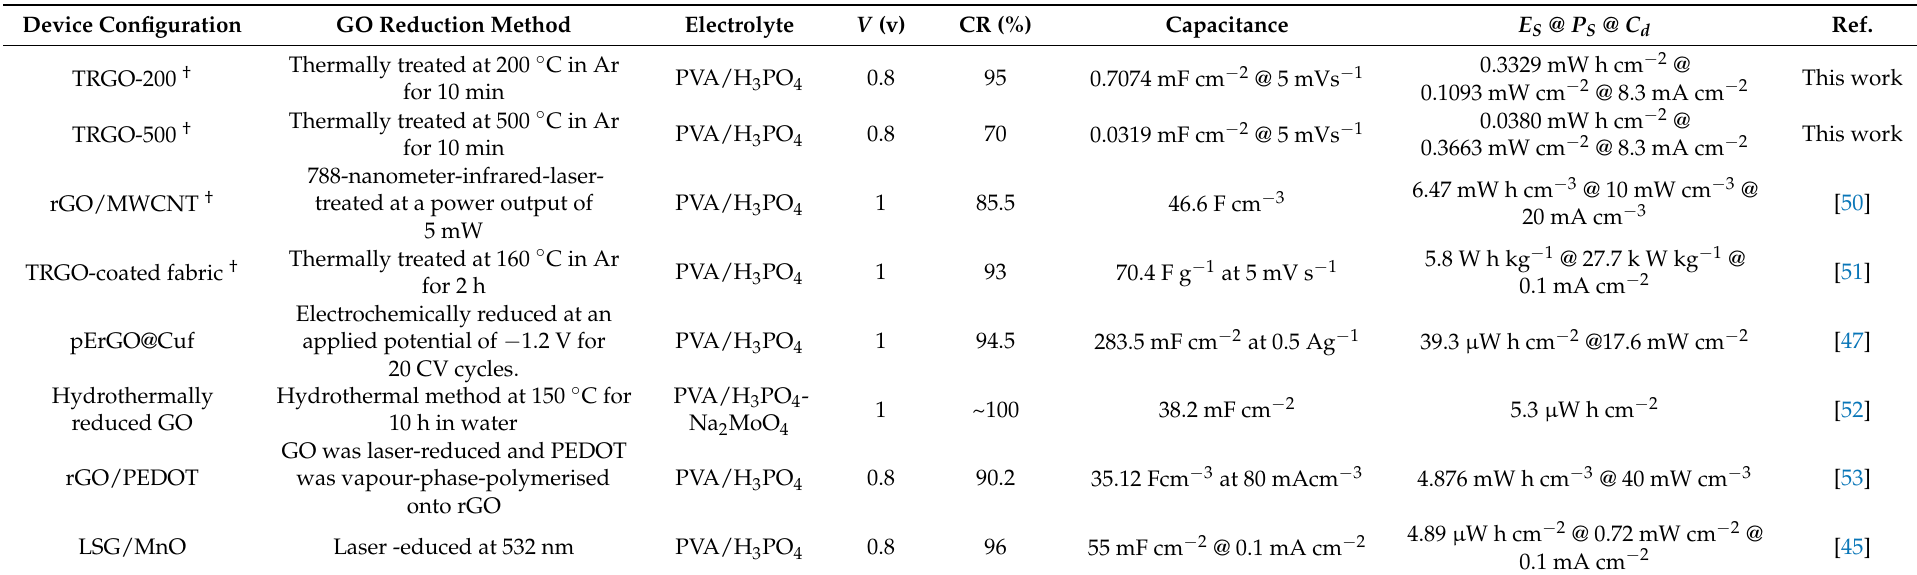
Table 1. Comparison of electrochemical performance of carbon-based